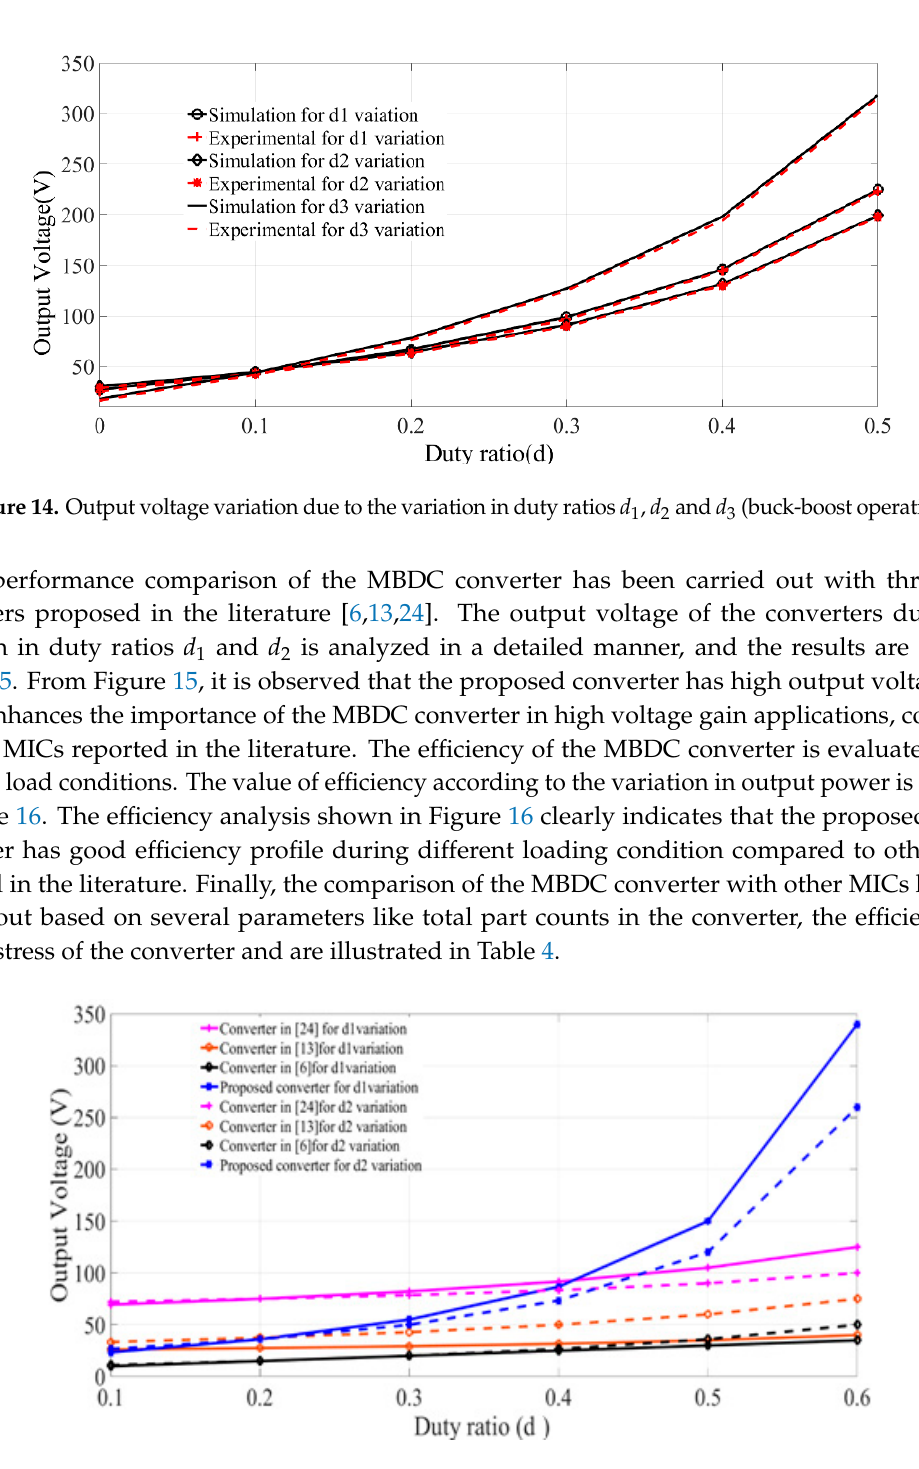
Figure 15. Output voltage variation due to the variation in duty ratios for different multi-input DC-DC converters (MICs).